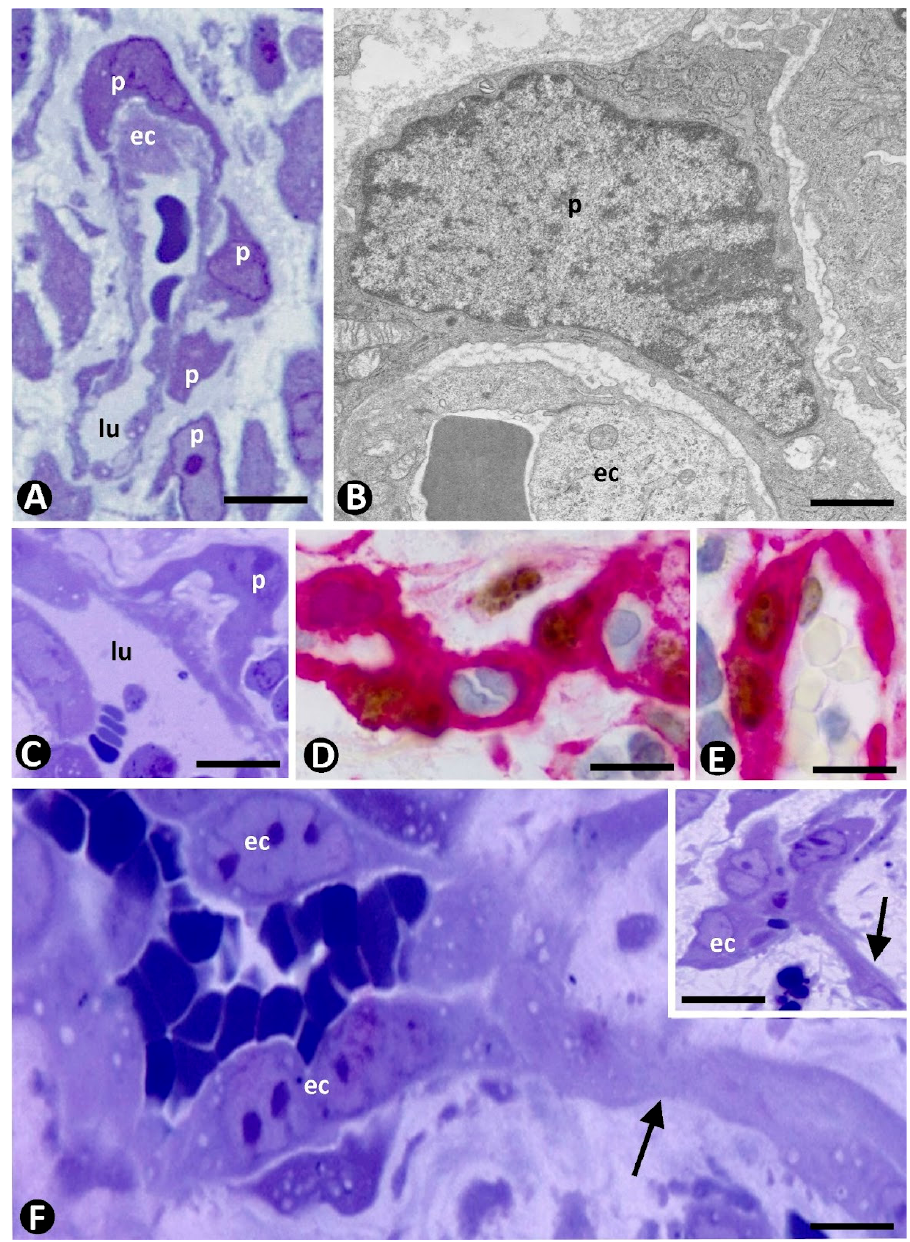
Figure 2. Pericyte during the initial stage of sprouting angiogenesis. ( A – C ): Presence in the parent vessels of pericytes (p) increased in size, with shortening of their processes, voluminous nuclei, prominent nucleoli, and abundant intracytoplasmic ribosomes. ( D , E ): Nuclear expression of ki-67 (brown) in pericytes with cytoplasmic expression of α SMA (red). ( F ) and insert: Sprouts of endothelial cells (arrows) devoid of pericytes. Endothelial cell: ec. Vessel lumen: lu. ( A , C , F ) and insert of ( F ): Semithin sections. Toluidine blue staining. ( B ): Ultrathin section. Uranyl acetate and lead citrate. ( D , E ): Double immunochemistry for anti-ki-67 and α SMA. Bar: ( A ): 12 µ m; ( B ): 0.8 µ m; ( C – E ): 15 mm; ( F ): 10 µ